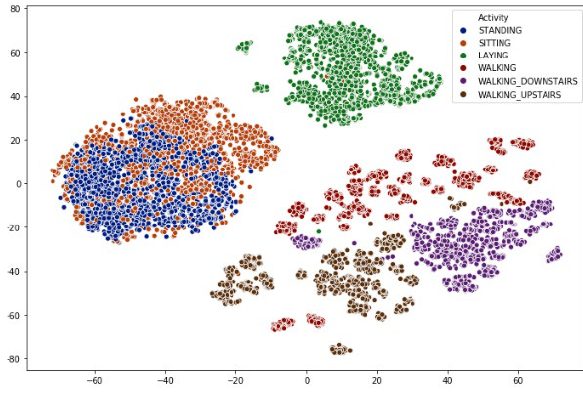
Figure 6. Proposed model for KNN in activity recognition